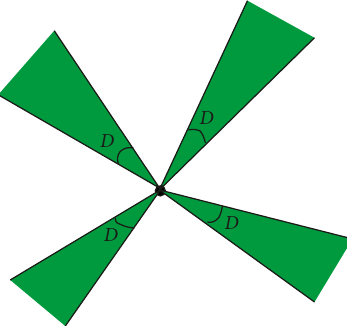
Figure 1: A node with 4 transmitting beams of angular width D .